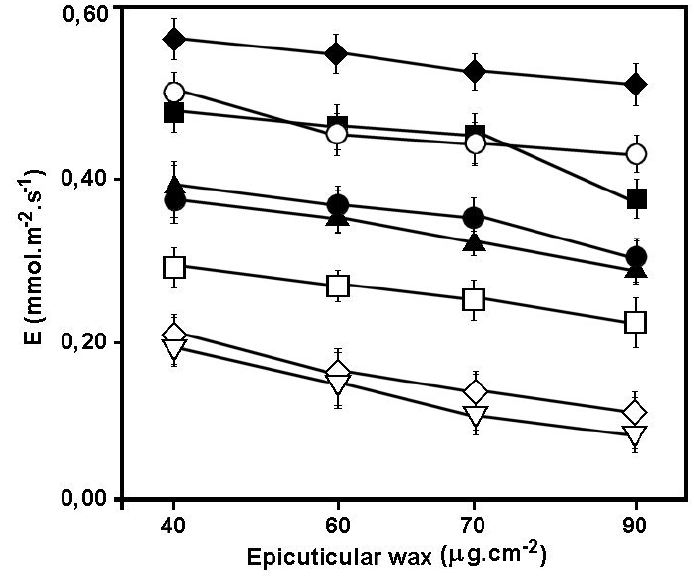
Fig. 2 – Evaporation rates ( E ) in Whatman paper discs impregnated with fo- liar epicuticular waxes of species from caatinga (empty symbols) and cerrado (full symbols). ( (cid:3) ) Aspidosperma pyrifolium , ( ♦ ) Capparis yco , ( (cid:1) ) Maytenus rigida ( (cid:5) ) Ziziphus joazeiro , ( (cid:2) ) Aristolochia esperanzae , ( (cid:3) ) Didymopanax • vinosum , ( ) Strychnos pseudoquina , ( (cid:4) ) Tocoyena formosa . Values correspond to means ± sd (n = 30), obtained at 25 ◦ C and 65% relative